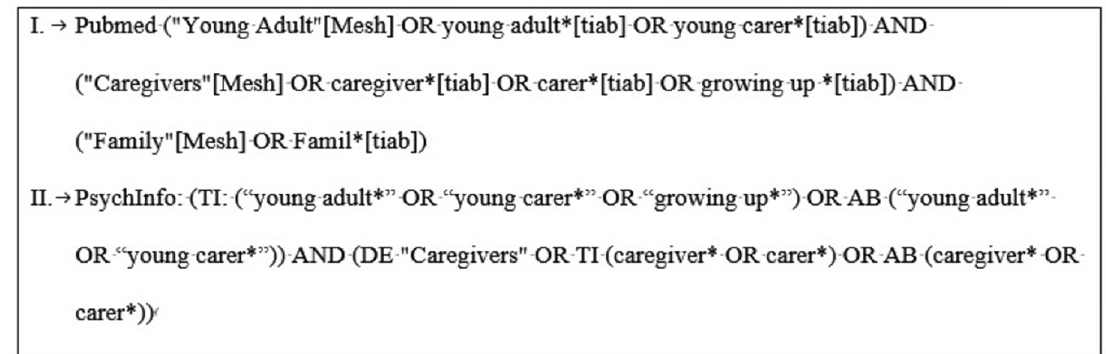
Figure 1. Database